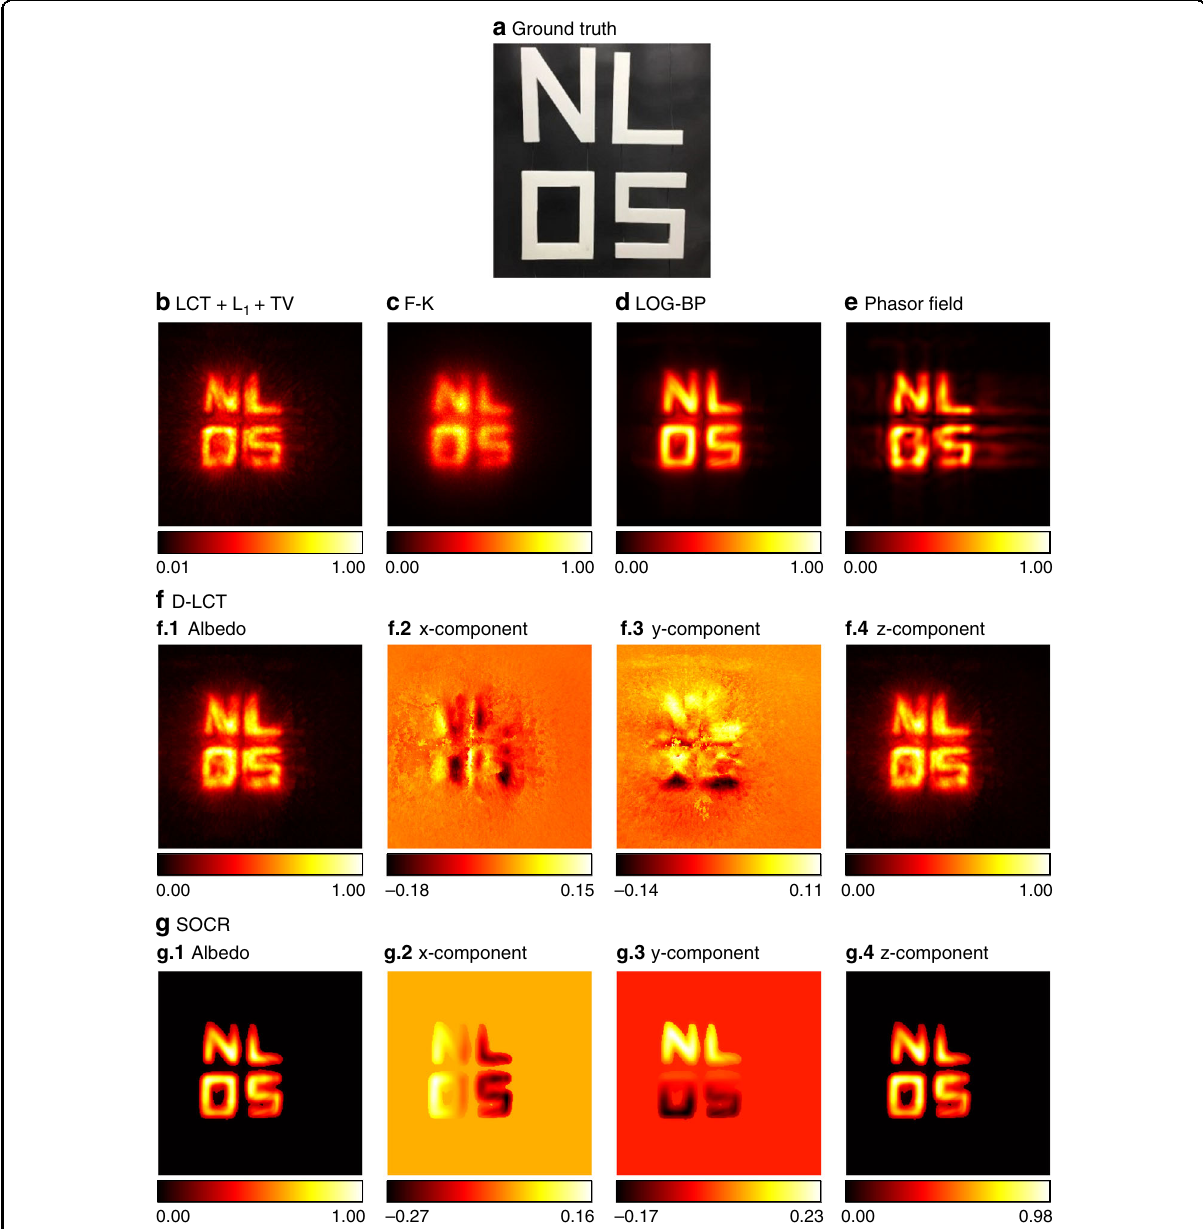
Fig. 12 Reconstruction results of the NLOS letters (non-confocal, 390 min). The ground truth is shown in a . Reconstructions are shown in b – g . Reconstruction results of the LCT + L 1 + TV, LOG-BP, phasor fi eld and D-LCT methods contain artifacts. The SOCR reconstruction is noiseless, and the gaps between the four letters are clearly